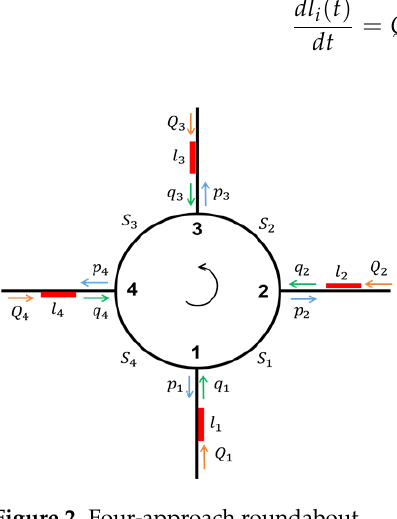
Figure 2. Four-approach